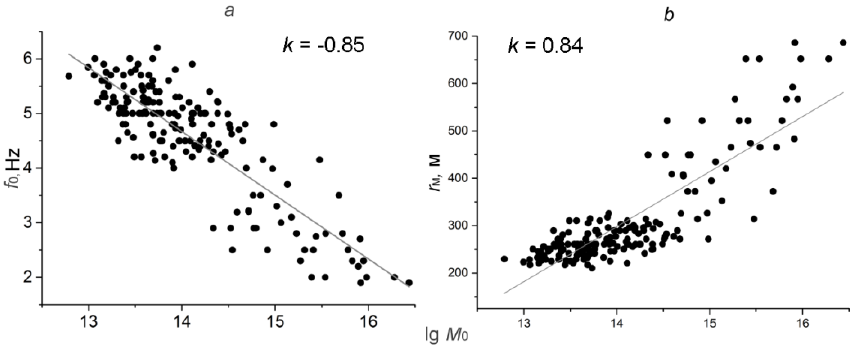
Fig. 7. The values of the corner frequency ( a ) and the source radius ( b ) in comparison with lg M 0 .